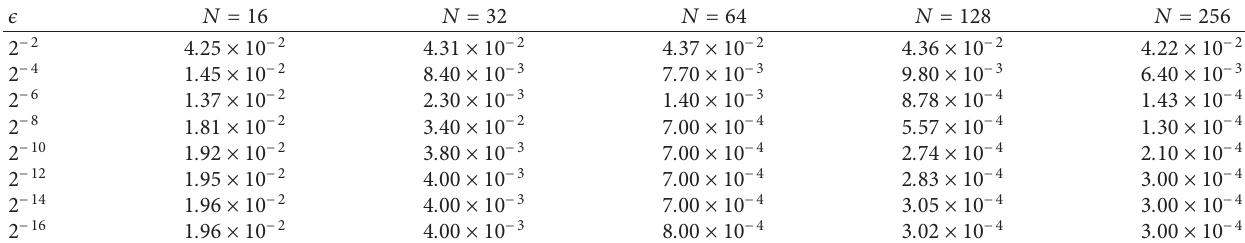
Table 7: L errors for Example 2 for different values of ϵ for quadratic basis and Gaussian weight functions. ∞